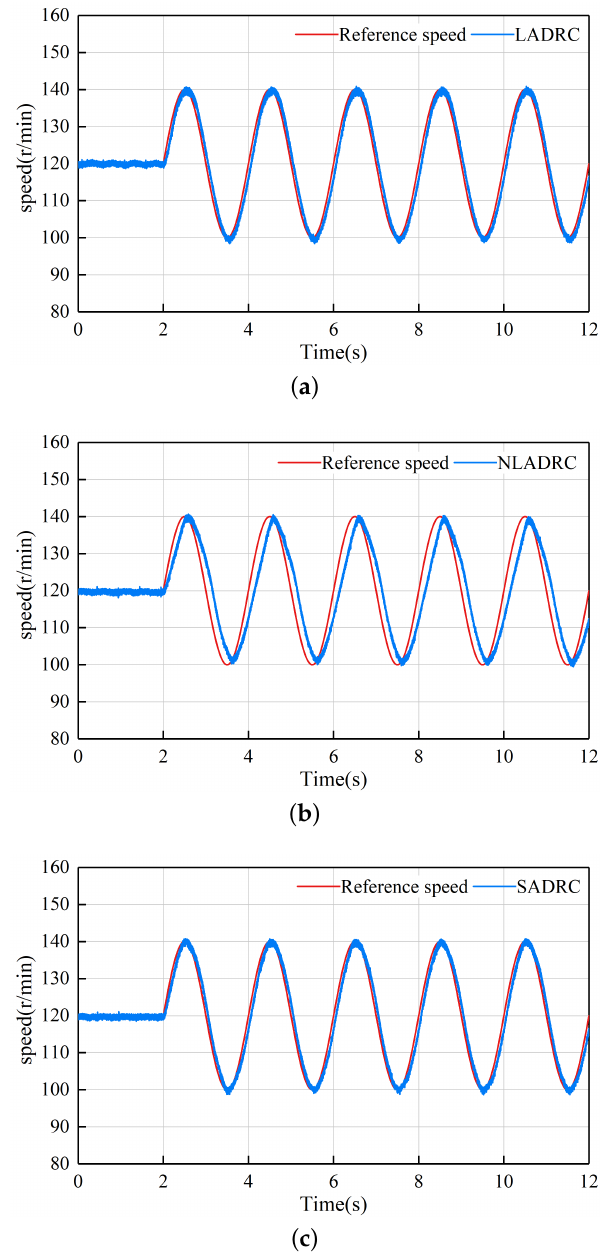
Figure 12. Tracking waveforms of the three control strategies under sinusoidal signal: ( a ) LADRC ( b ) NLADRC ( c )